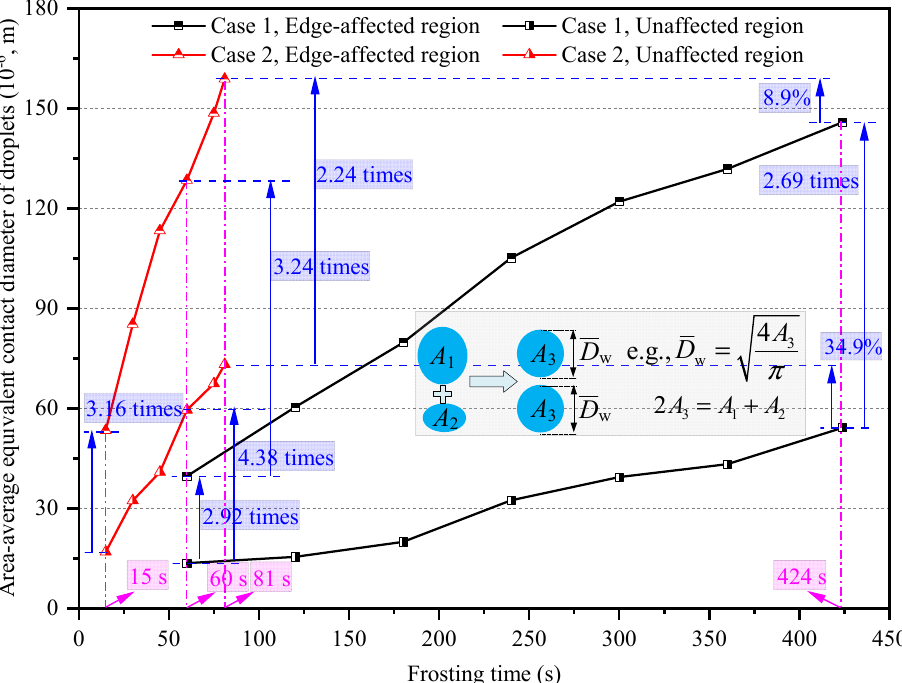
Figure 5. The area-average equivalent contact diameter of water droplets in edge-affected and unaffected regions.